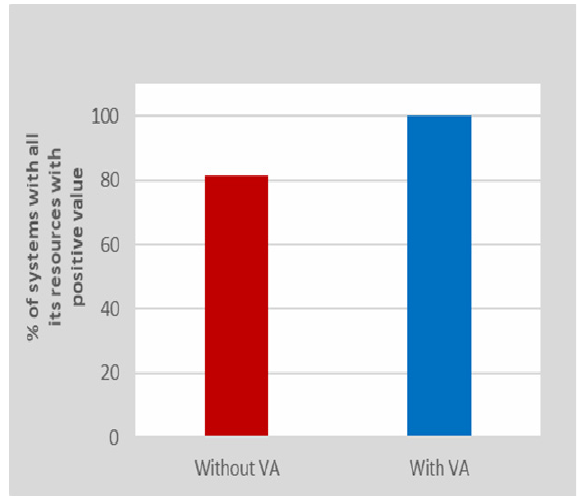
Figure 9. Aggregate effort without VA ( k wn ) and with VA ( k vn